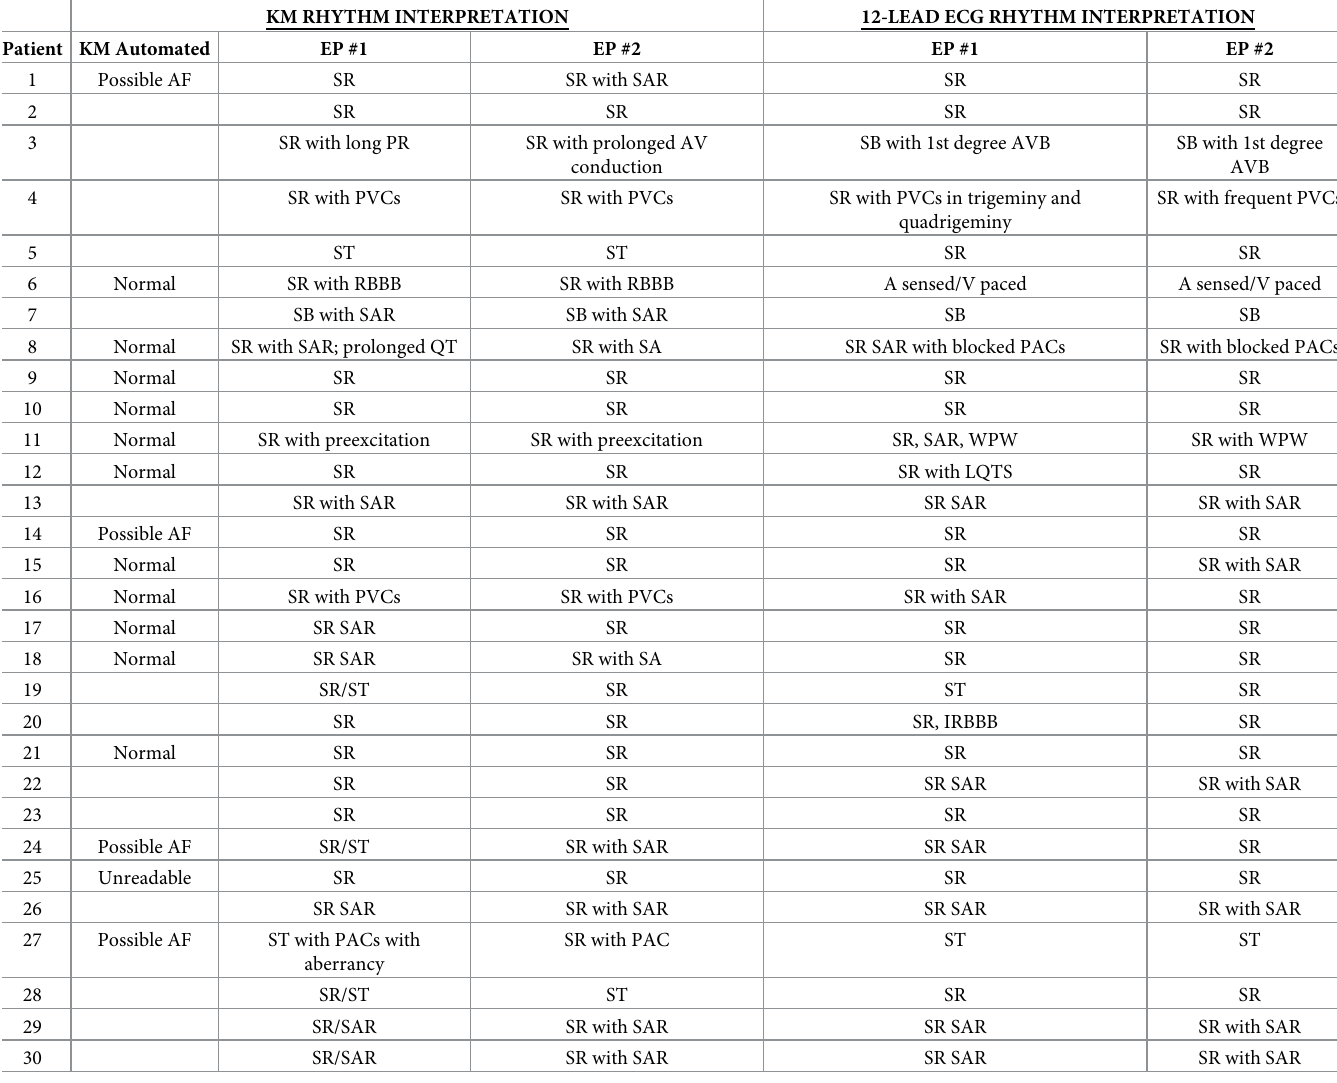
Table 3. Rhythm interpretation and comparison by two pediatric electrophysiologists. Abbreviations: SR = sinus rhythm, ST = sinus tachycardia, SB = sinus bradycar- dia, SAR = sinus arrhythmia, PAC = premature atrial contraction, PVC = premature ventricular contraction, IRBB = incomplete right bundle branch